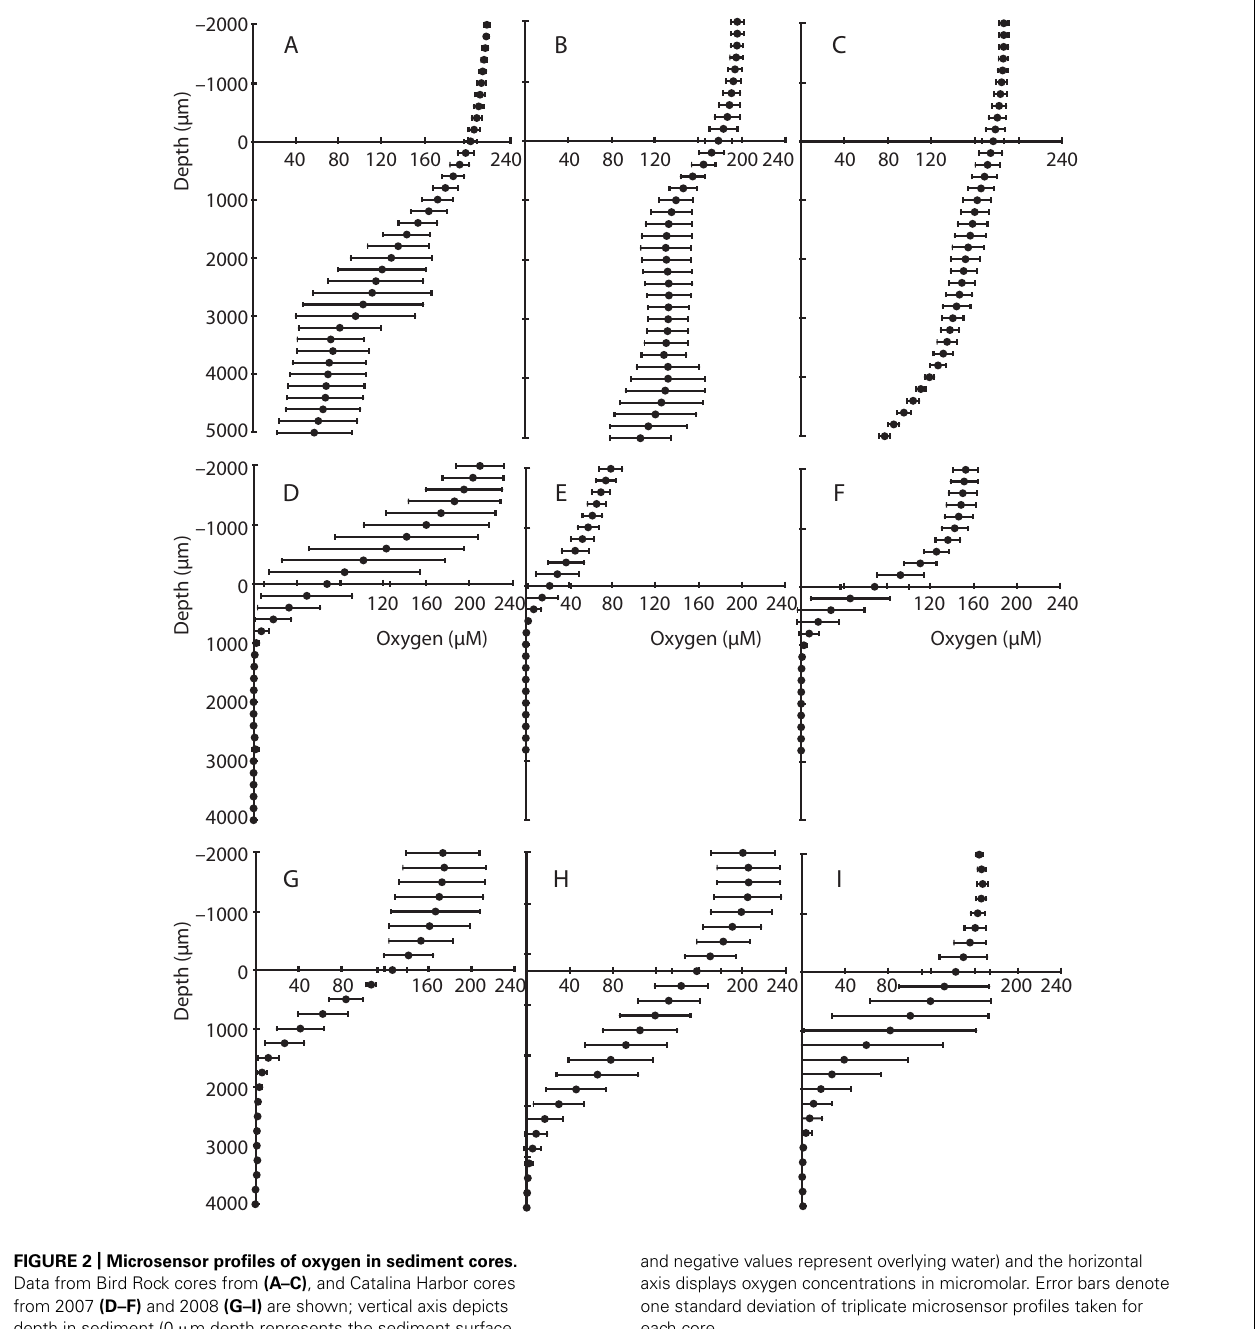
and negative values represent overlying water) and the horizontal axis displays oxygen concentrations in micromolar. Error bars denote one standard deviation of triplicate microsensor profiles taken for each